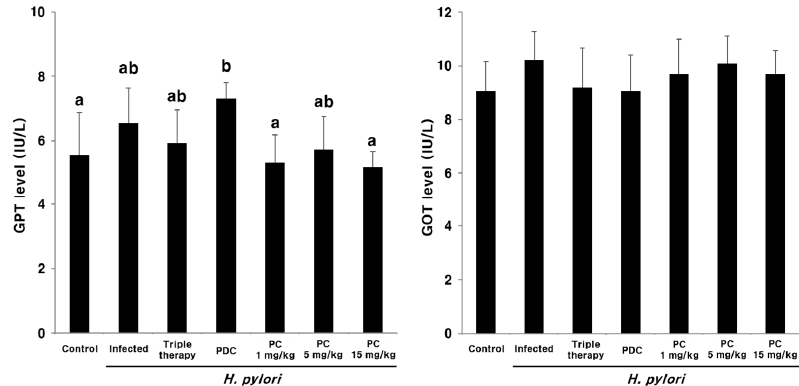
Figure 9. Plasma glutamate pyruvate transaminase (GPT) and glutamate oxaloacetate transaminase (GOT) levels after 3-pentylcatechol treatment. Different letters (a and b) indicate a significant difference ( p < 0.05), ascertained via the Tukey–Kramer test.